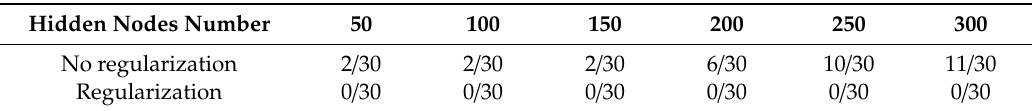
Table 3. Statistics of over fitting times.